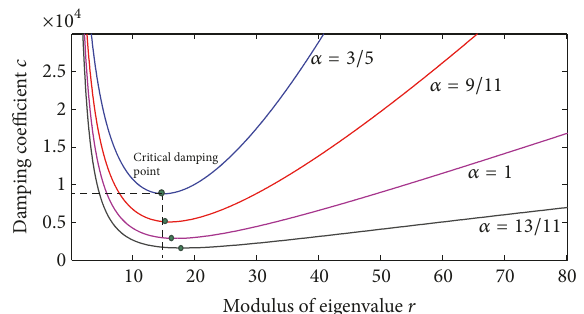
Figure 1: The relation between the three parameters in (12).